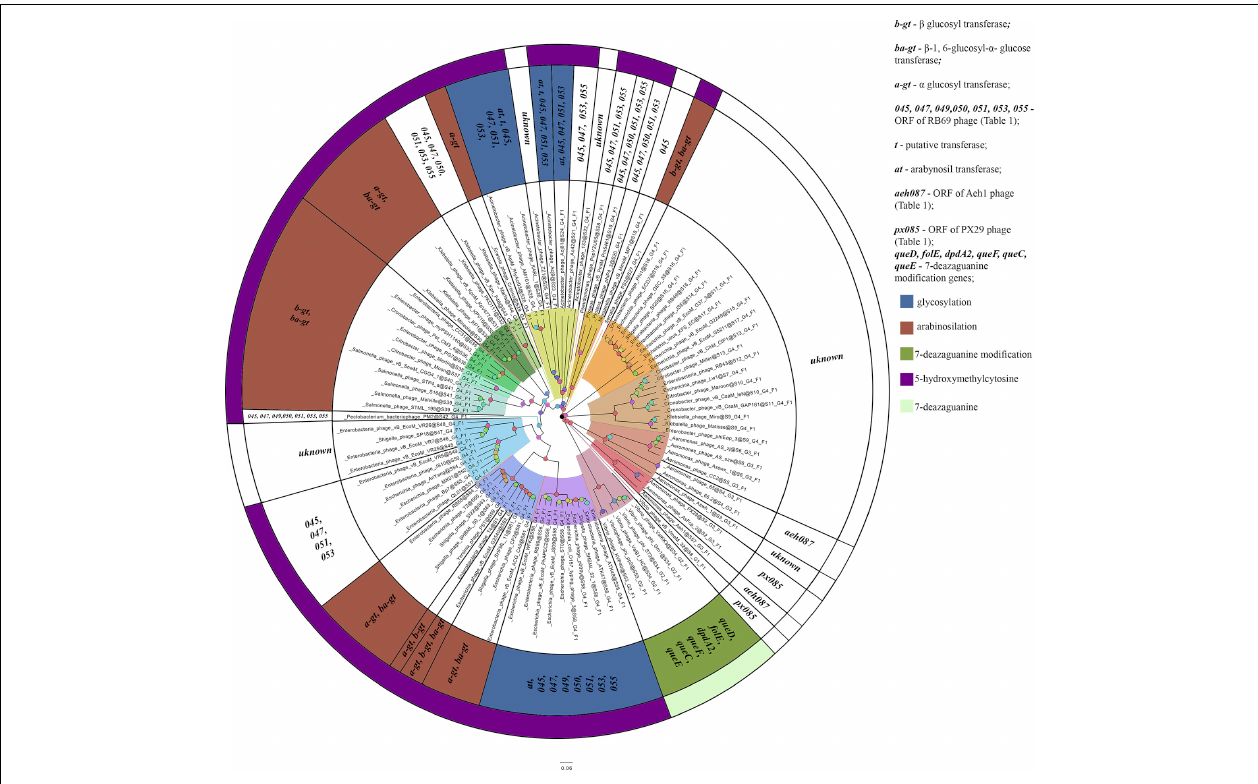
FIGURE 5 | A number of gene sets associated with the synthesis of non-canonical bases. The colors indicate known modifications of non-canonical bases and the non-canonical bases as they are. The genes whose products involved or presumably involved in base modification are additionally